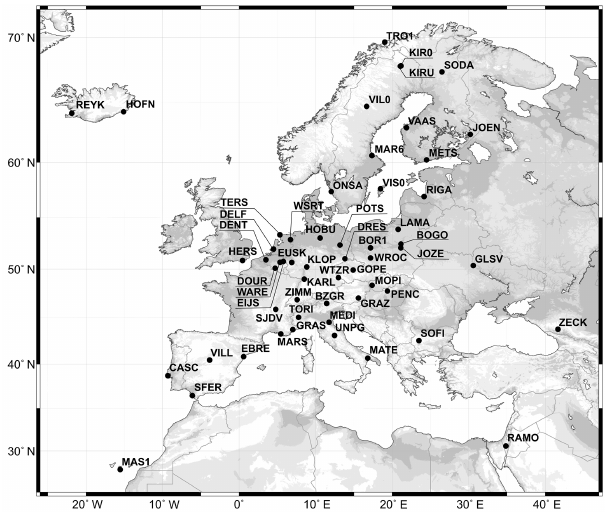
Figure 1. Distribution of stations with 16-year ZTD time series in- cluded in the